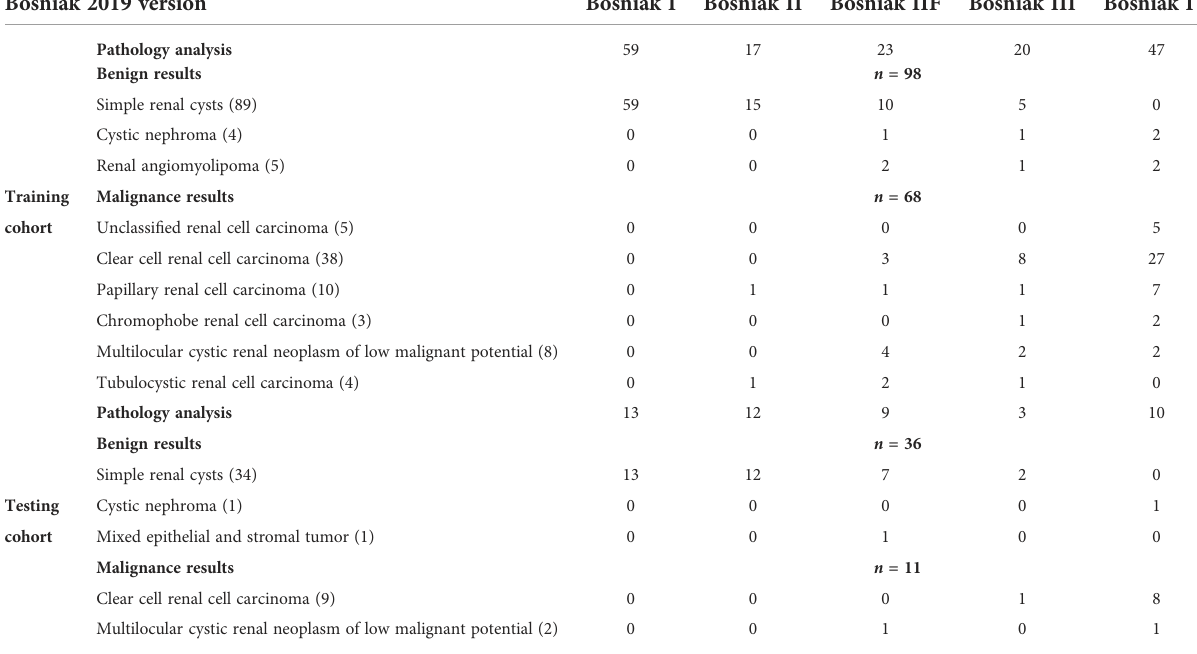
TABLE 1 Detailed distribution of the Bosniak 2019 classi fi cation and pathology results in the training cohort and testing cohort. Bosniak 2019